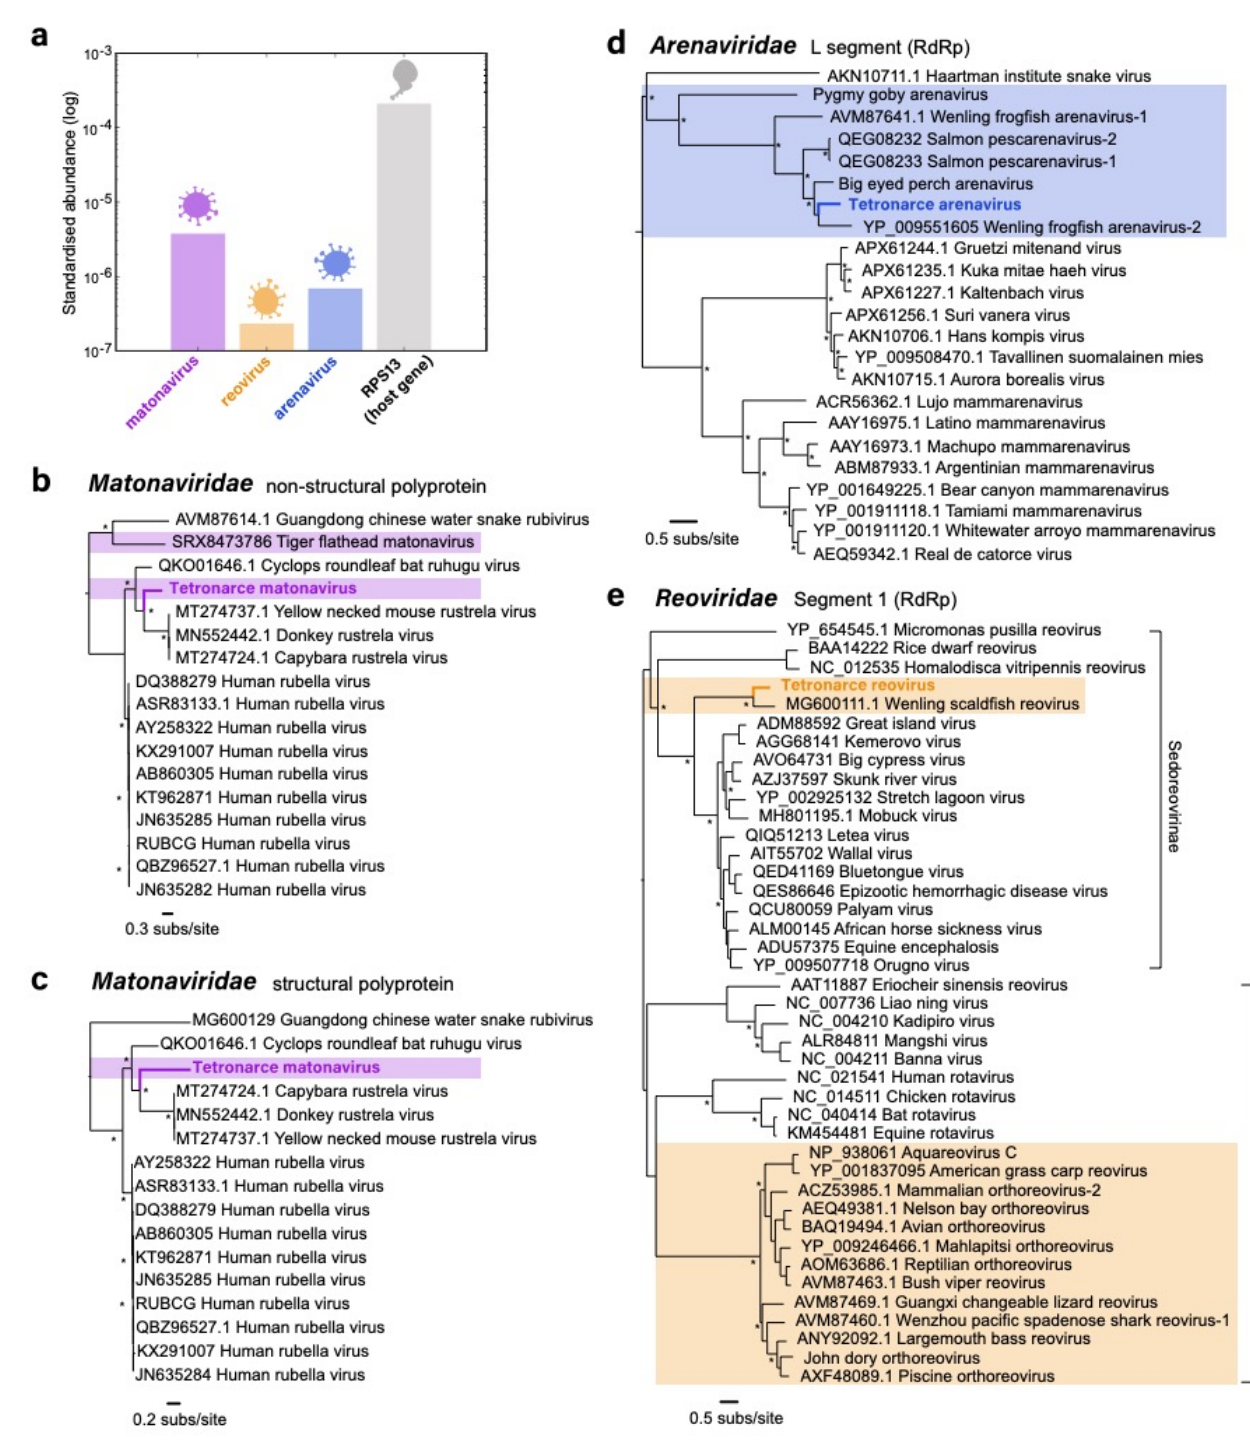
Figure 1. ( a ) Standardised abundance of viral reads (log) from the novel viruses (matonavirus, reovirus, and arenavirus) and a host gene (RPS13). ( b , c ) Phylogenetic trees of the non-structural and structural polyproteins of Tetronarce matonavirus within the Matonaviridae . ( d ) Phylogenetic tree of the L segment (RdRp) of Tetronarce arenavirus within the Arenaviridae . ( e ) Phylogenetic tree of segment 1 (RdRp) of Tetronarce reovirus within the Reoviridae . All phylogenetic trees are rooted at the midpoint. Viruses from fish species are highlighted within each phylogeny. Names of novel viruses identified in this study are in bold and highlighted. Nodes with bootstrap support values of >70% are indicated with asterisks (*).